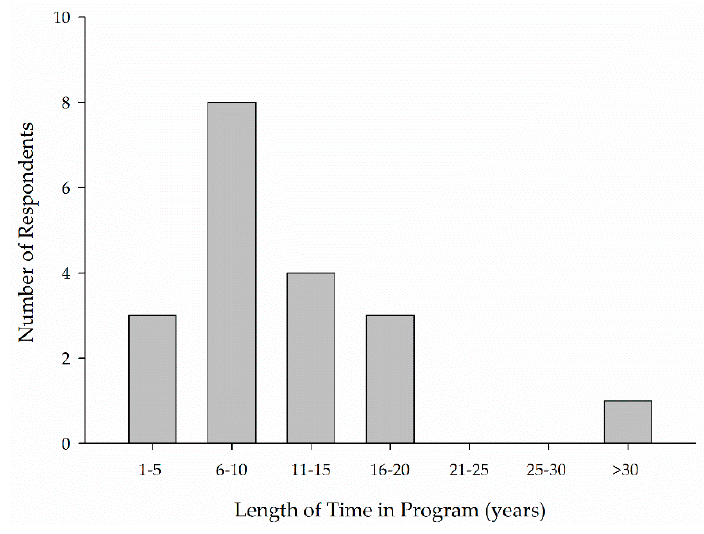
Figure 2. Length of time, on average, horses are active in a center’s